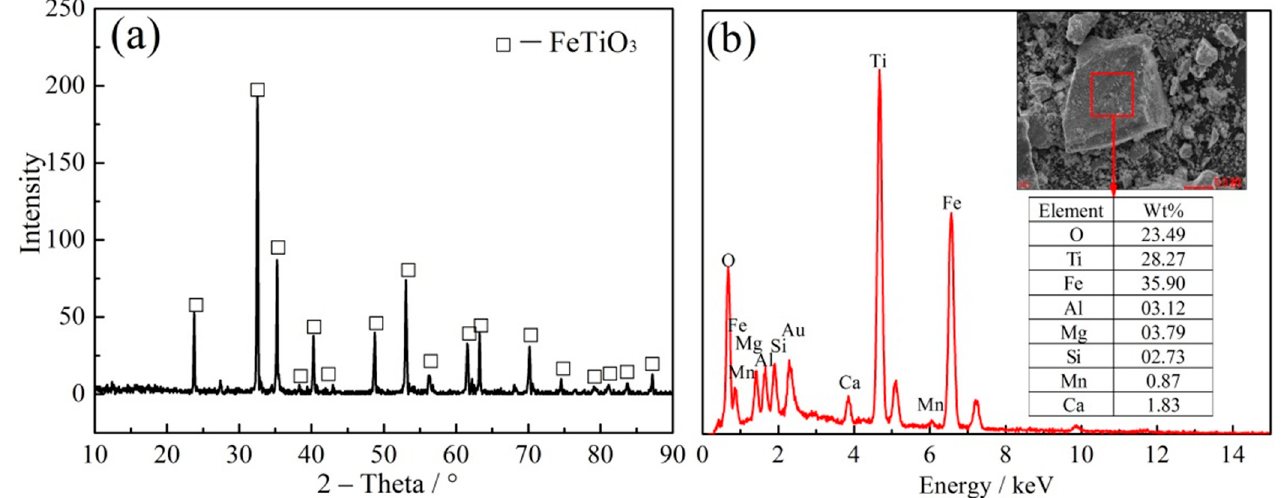
Figure 1. ( a ) XRD pattern and ( b ) EDS analysis of the ilmenite sample. Table 1. The main chemical composition of ilmenite concentrate (wt %).